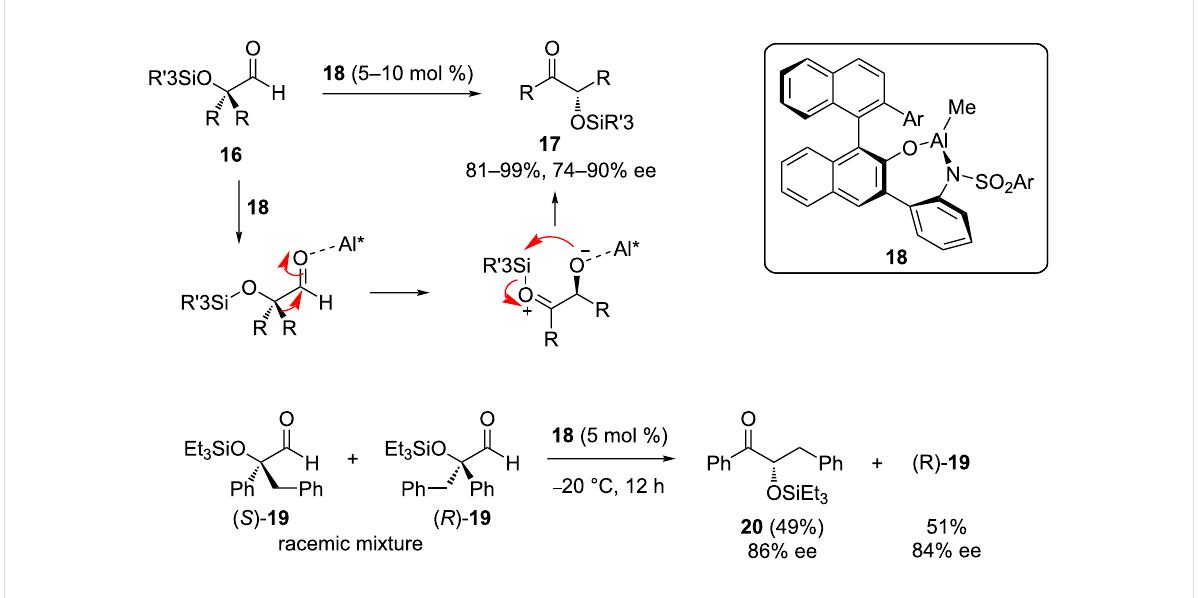
Figure 5: Asymmetric rearrangement of α , α -dialkyl- α -siloxyaldehydes 16 to α -siloxyketones 17 catalyzed by chiral organoaluminum Lewis acid 18 . The catalyst is also capable of kinetic resolution of a mixture of enantiomeric substrates. Al* = 18 .